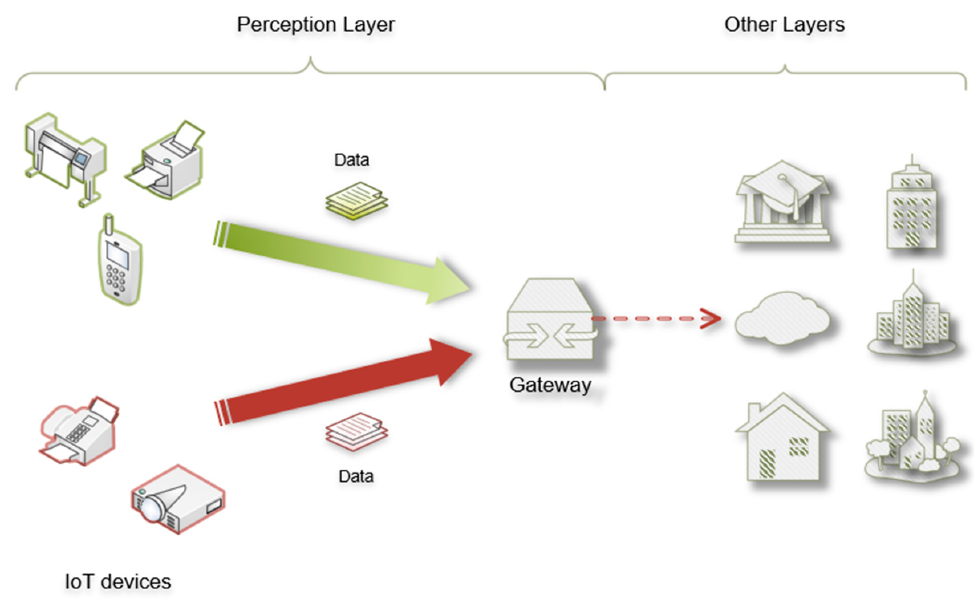
Figure 1. The attacker model in the real scenario.